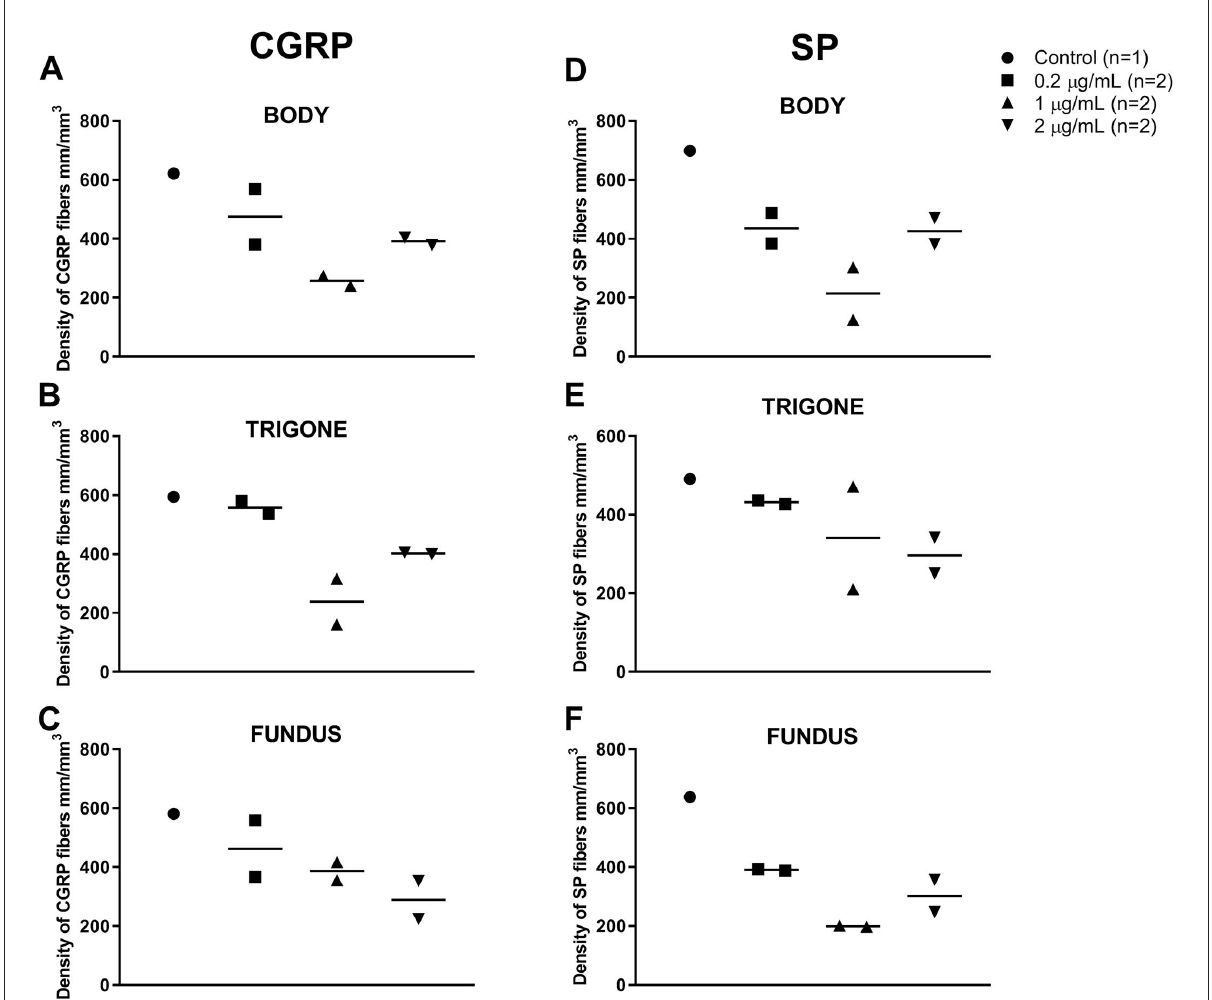
FIGURE3 Individual values and median of the density of nerve fibers in the urinary bladder of 7 healthy adult sexually intact female cats expressing CGRP (A–C) and SP (D–F) in the body (A, D) , trigone (B, E) , and fundus (C, F) after saline (control; n = 1) or RTX treatment (14 days post-application) at doses of 0.2 ( n = 2), 1 ( n = 2), or 2 ( n = 2) µ g/mL diluted with sterile saline to a total volume of